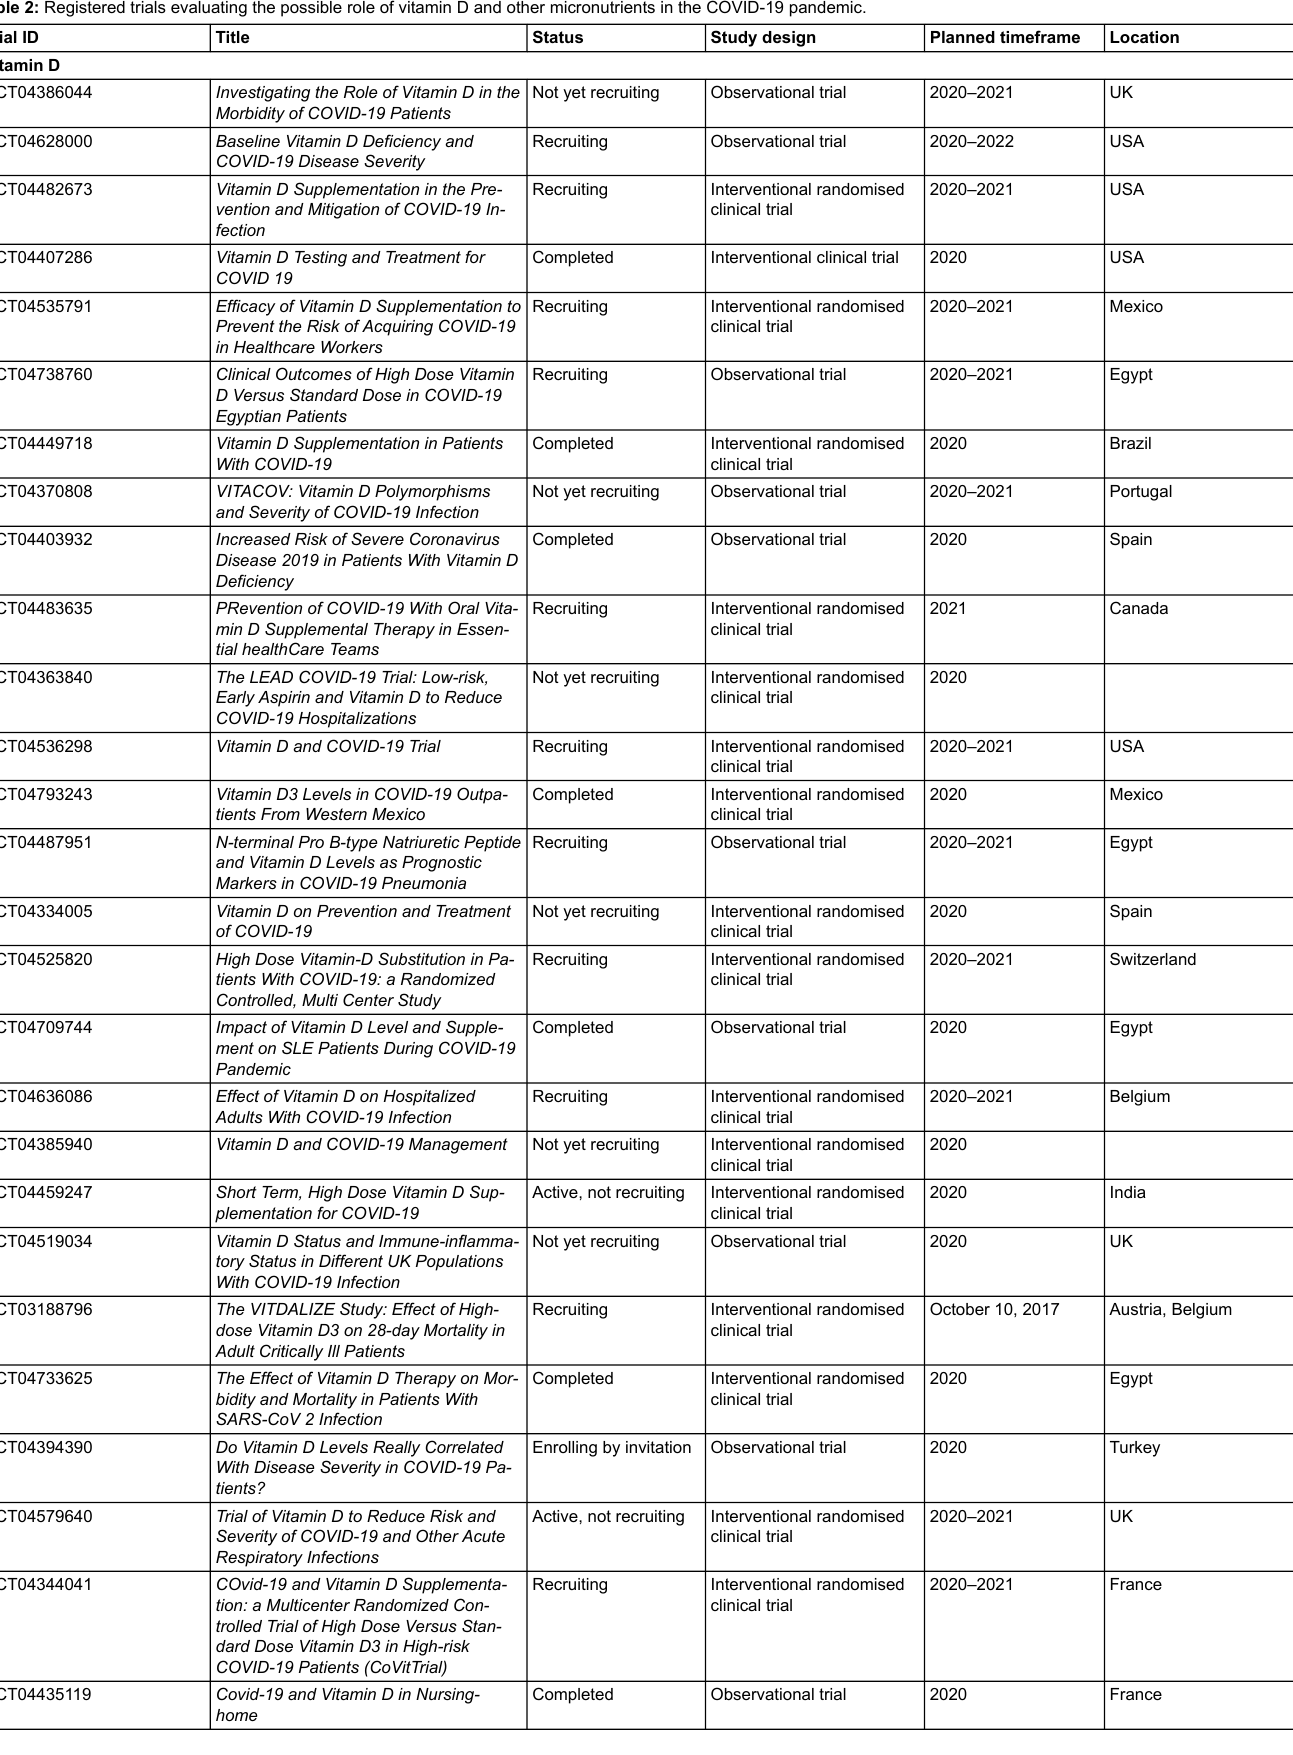
Table 2: Registered trials evaluating the possible role of vitamin D and other micronutrients in the COVID-19 pandemic. Trial